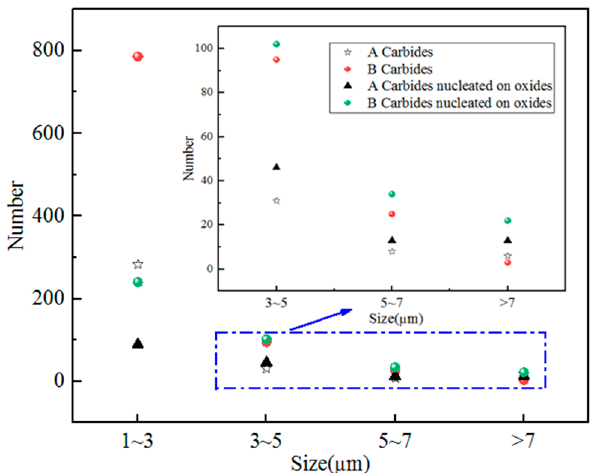
Figure 7. Number distribution of various sizes for carbides and carbides nucleated on oxides.